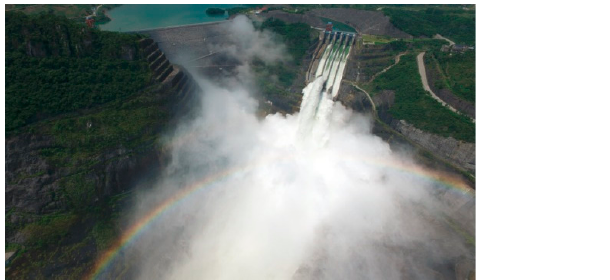
Figure 10. FDA scene and atomization rain intensity monitoring points of Shuibuya Hydropower Station.